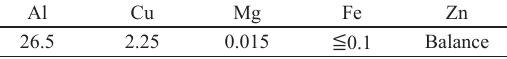
Table 1. Chemical composition of the ZA27 alloy (mass fraction, %).